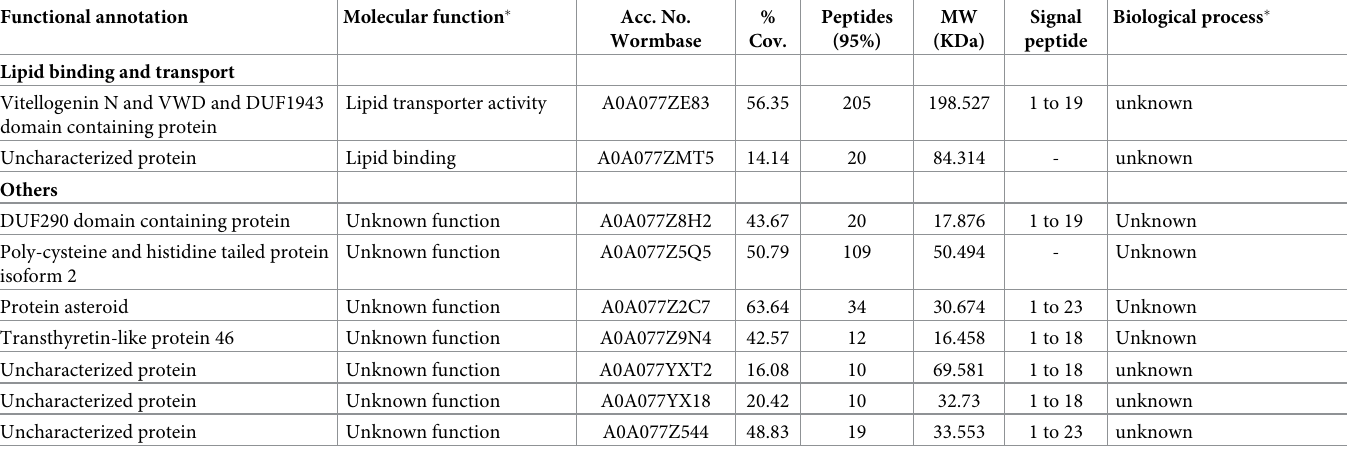
1-DE and immunoblot analysis of T . trichiura EE and FE To identify the species-specific parasite antigens, 1-DE SDS-PAGE and Western blots were performed on EE and FE with serum from naturally infected AGMs. For the EE, the possible identity of the antigens revealed in Western blots (Fig 2, Lane 1) was investigated by matching the molecular weights of the bands seen with those of proteins identified in the EE proteome and are presented in Table 2. In addition, the same specific areas on SDS-PAGE gels (1G and 2G) (Fig 2, Lane 2) corresponding to the bands in the Western blots were excised and used for confirmatory proteomic analysis by LC-MS/MS and presented in Table 3.